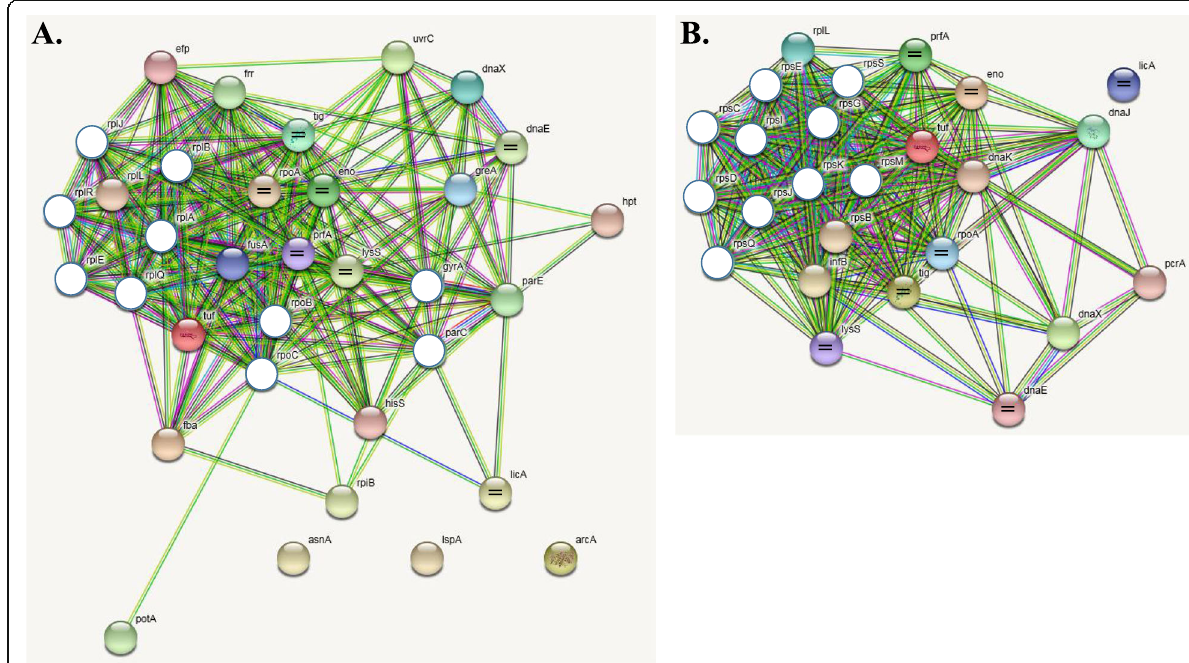
Fig. 5 The protein-protein interaction network analysis tool (STRING database) was used to analyze the proteins identified in the fractions of Mycoplasma fermentans MFI cultured in anaerobic ( a ) and aerobic ( b ) conditions. A network was build based on medium confidence (0.4) evidence. Proteins are indicated by nodes labeled with the gene symbol. The network was enriched in interactions, using the intersection of 10 additional proteins that were labeled as white nodes in the figure. Mycoplasma hominis was used as reference genome. The proteins labeled with the symbol ‘ = ’ are present both in anaerobiosis and aerobiosis. a : represents the fraction of MFI cultured in anaerobic conditions showing 246 interactions between individual proteins (or nodes). In the analysis, STRING did not include the following proteins: argF, malL, xfp, p37 and pmpr (exclusive of anaerobic MFI) abca, ptsI, pdhA, nrnA and hysA (commonly present in both anaerobic and aerobic MFI). b : shows the fraction of MFI cultured in aerobic conditions depicting 212 interactions between individual proteins. In the analysis, STRING did not include the following proteins: had, kduI, ndt, rlmb and pstb (exclusive of aerobic MFI), abca, ptsI, pdhA, nrnA, and hysA (commonly present in both anaerobic